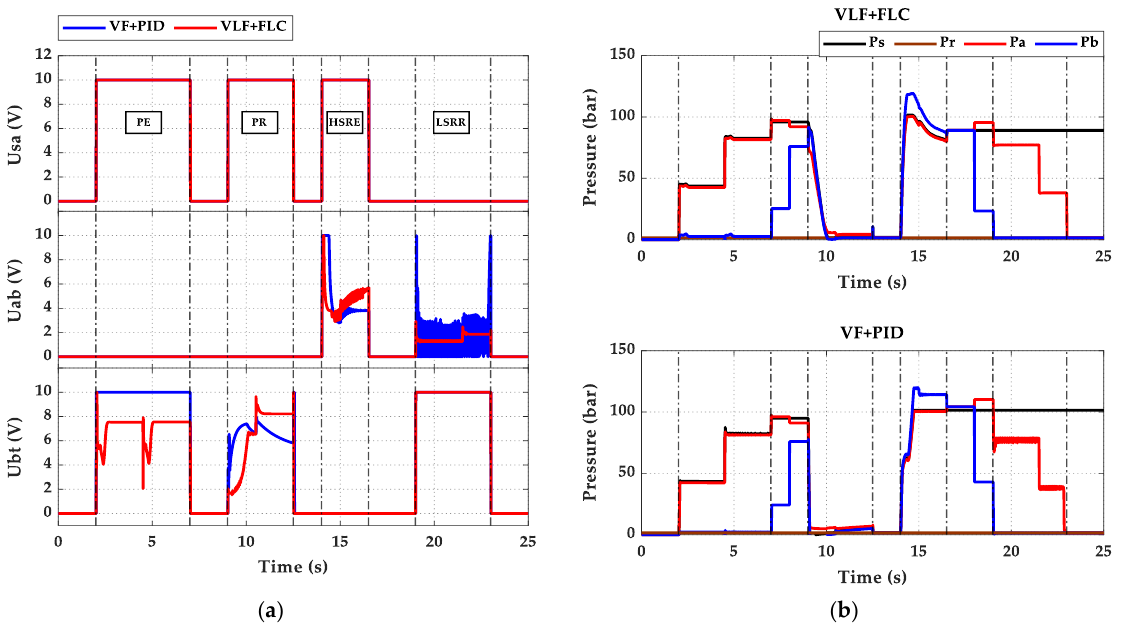
Figure 13. The comparison of ( a ) valve control signal and ( b ) pressure of the system on both meth-